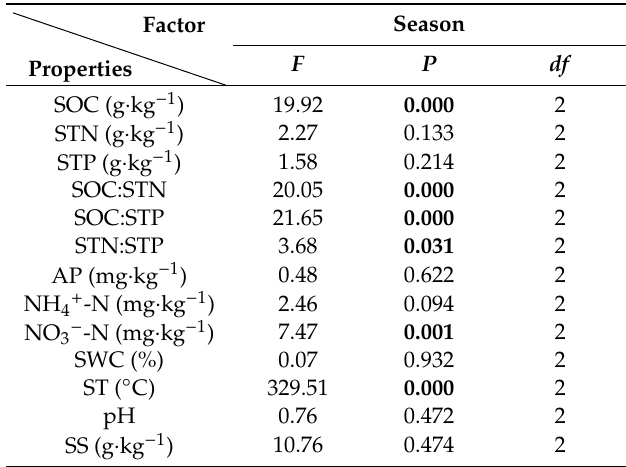
Figure 1. Di ff erence in leaf stoichiometry of P. australis among di ff erent stages of the growing season. LC, leaf carbon concentration; LN, leaf nitrogen concentration; LP, leaf phosphorus concentration. Di ff erent small letters mean a significant di ff erence at the 0.05 level. Table 1. E ff ects of season on soil